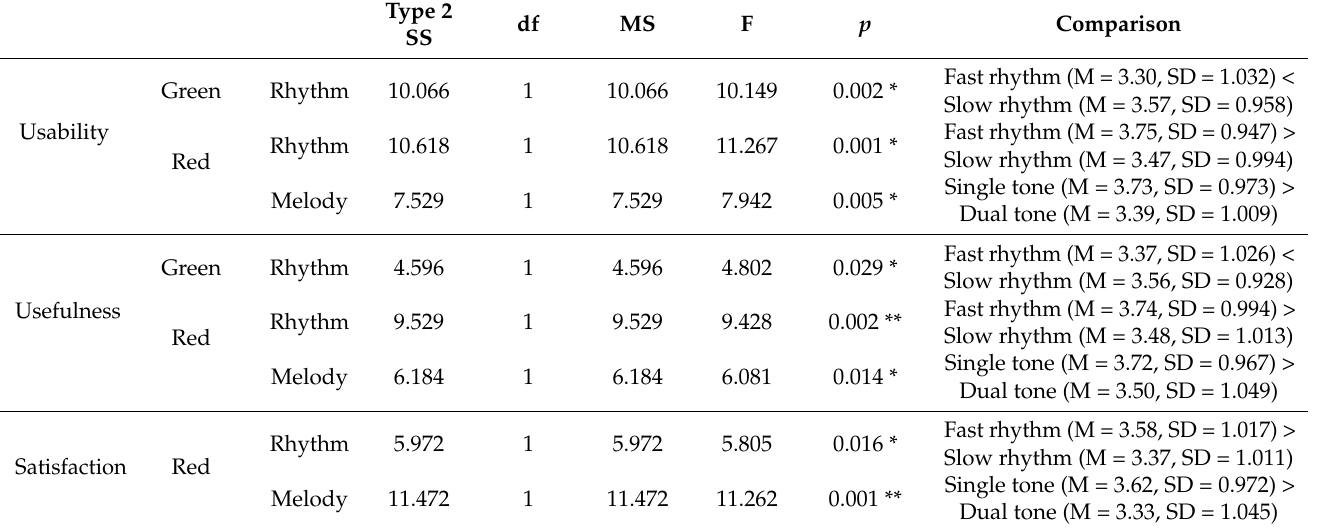
Table 7. Verification and analysis results of simple main effects of subjective cognition in deceleration